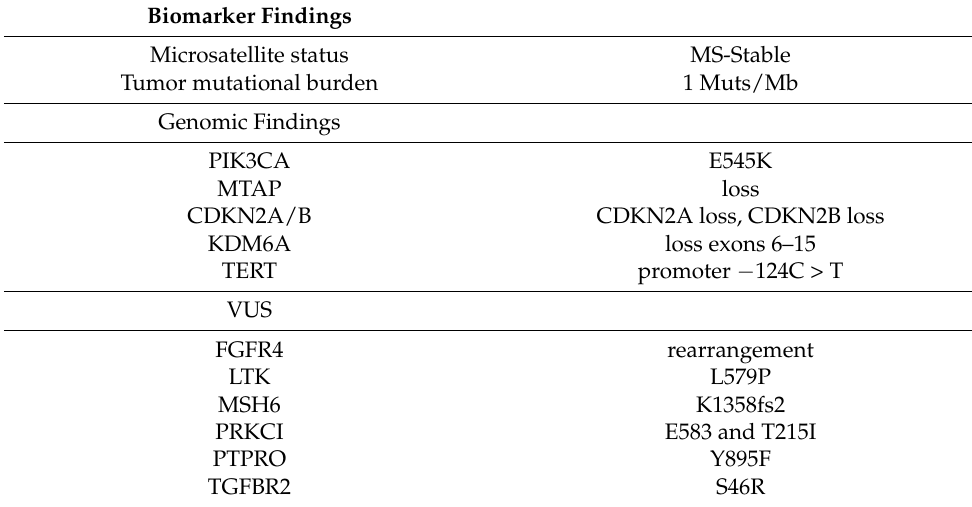
Table 2. Gene mutations detected in the cancer genome